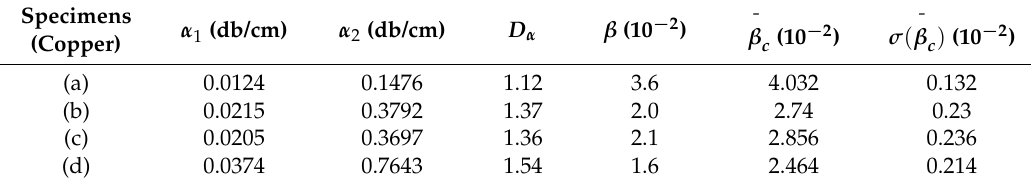
Table 3. Experimental results of ultrasonic testing in copper plates.